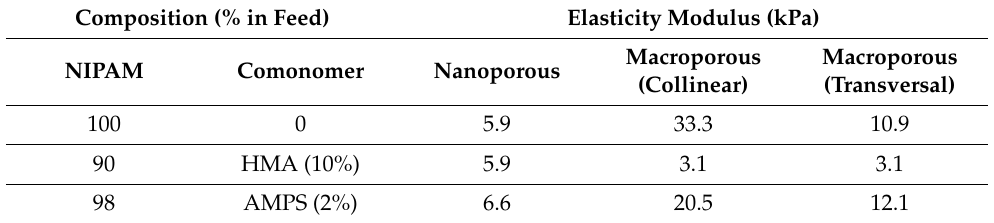
Table 3. Effect of copolymer composition and fabrication method on the elastic modulus of the